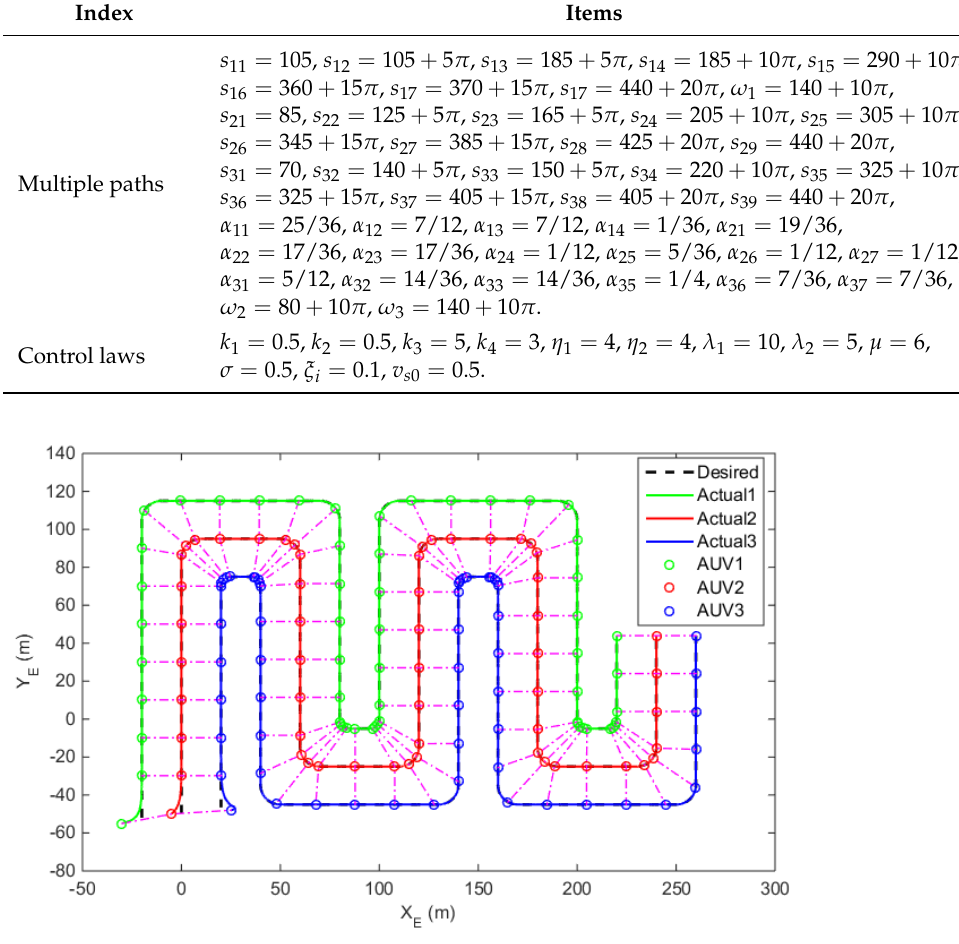
Table 2. Path parameters and control parameters.